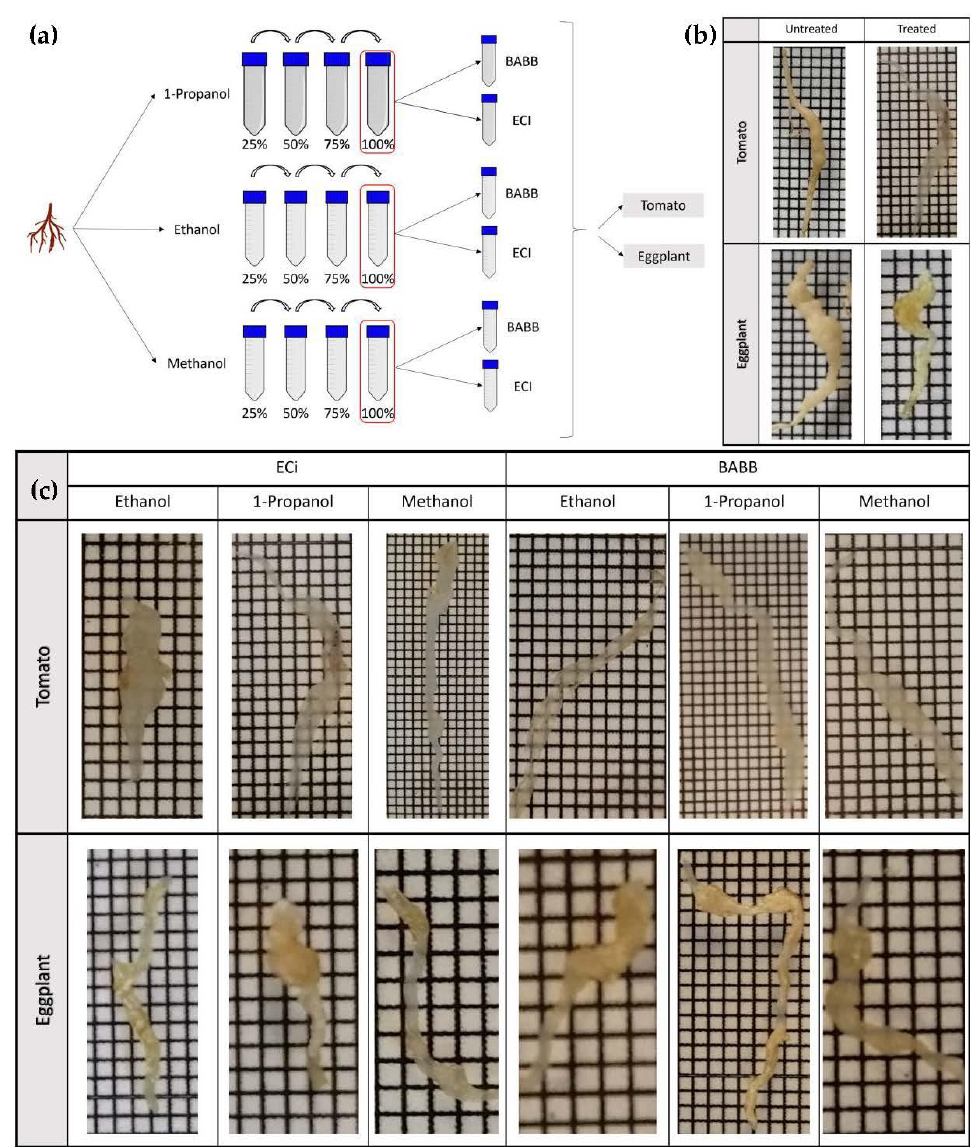
Figure 1. ( a ) Schematic representation of the procedure followed for the clarification of root samples. ( b ) Optical clearing of different samples of tomato and eggplant roots infected by M. incognita 6 weeks after nematode inoculation using a combination of 1-propanol and ECi as a dehydrating agent and clearing reagent, respectively. Photographs were taken before and after treatment with a clearing solution. ( c ) Comparison of the clearing efficiency in tomato and eggplant samples after treatment. Grid scale: 1 mm.